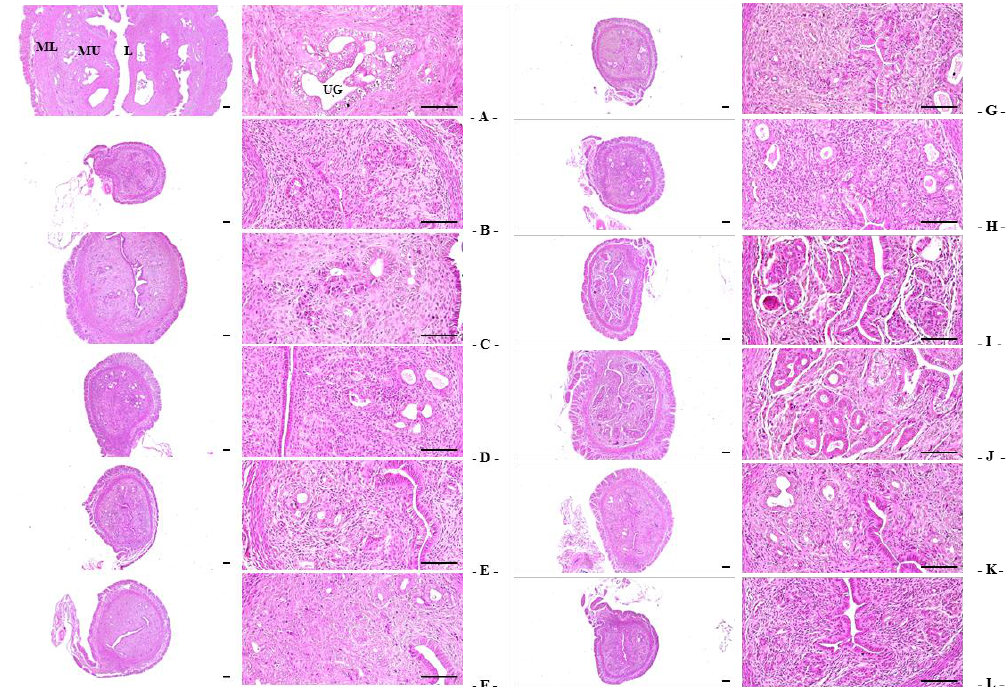
Figure 3. Representative histological images of the left uterus horn, taken from sham-operated or